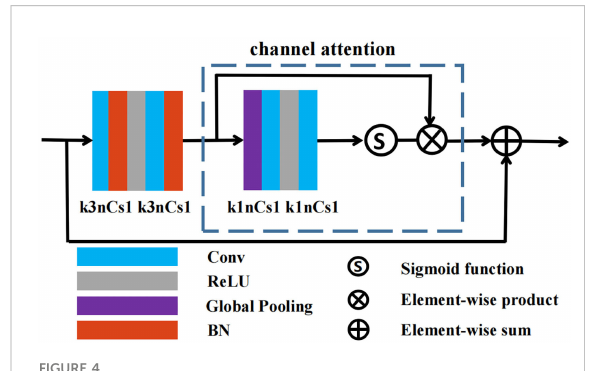
FIGURE 4 The structure of the residual channel attention block